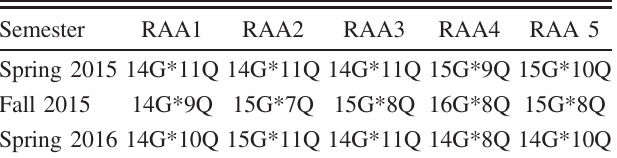
TABLE I. Number of peer groups and RAA questions. G: Group, Q: Questions. Each RAA includes 7 to 11 problems on related physics content. There is a minimum of 14 and a maximum of 16 groups of students answering the questions in each RAA set for each